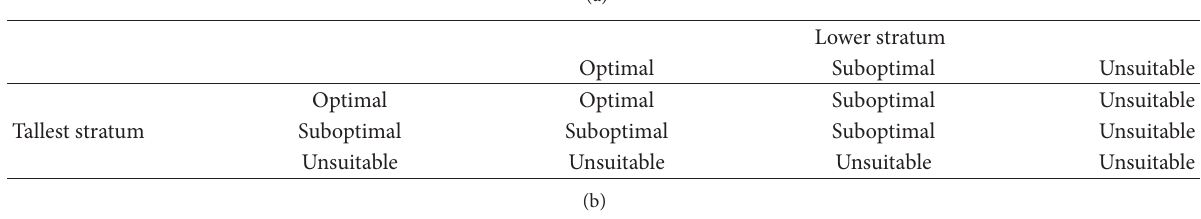
Table 2: (a) Matrix of vegetation suitability for Isoodon obesulus obesulus and (b) suitability classification of the tallest and lower strata for Isoodon obesulus obesulus. Specht et al. [58] classes are used in the table for vegetation structural